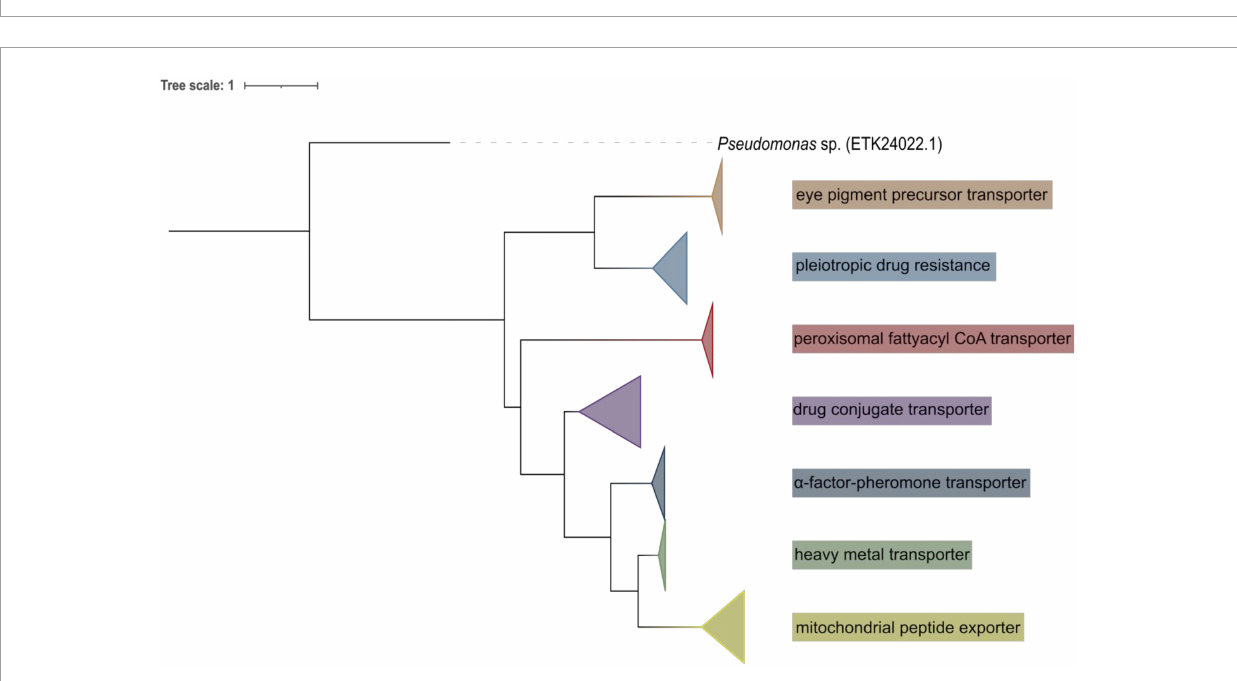
FIGURE5 Maximum-likelihood tree of P450 predicted from all five yeast genomes.